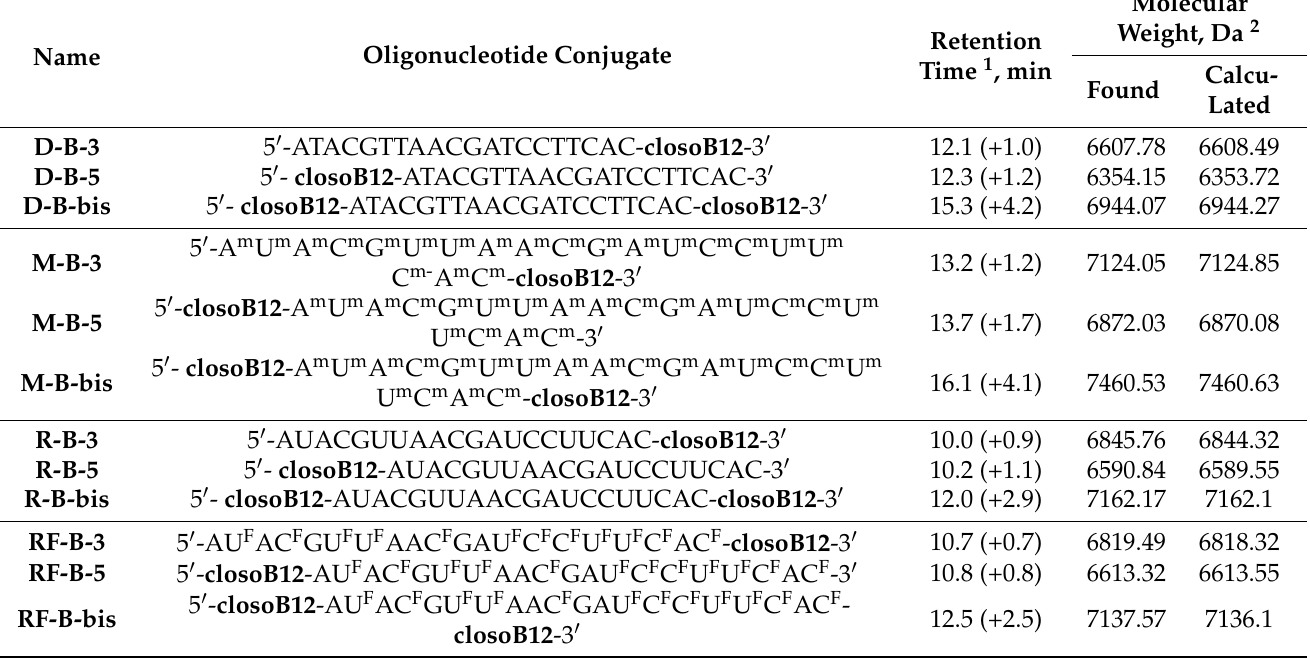
Table 1. Oligonucleotide conjugates with closo